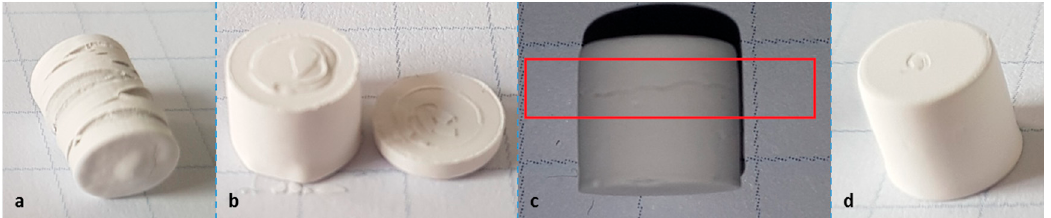
Figure 14. Detailed depiction of the thermomechanical analysis from Figure 13 .